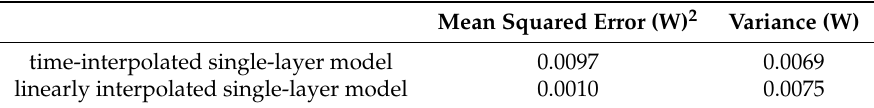
Table 2. The 10-fold validation results for single-layer LSTM models.